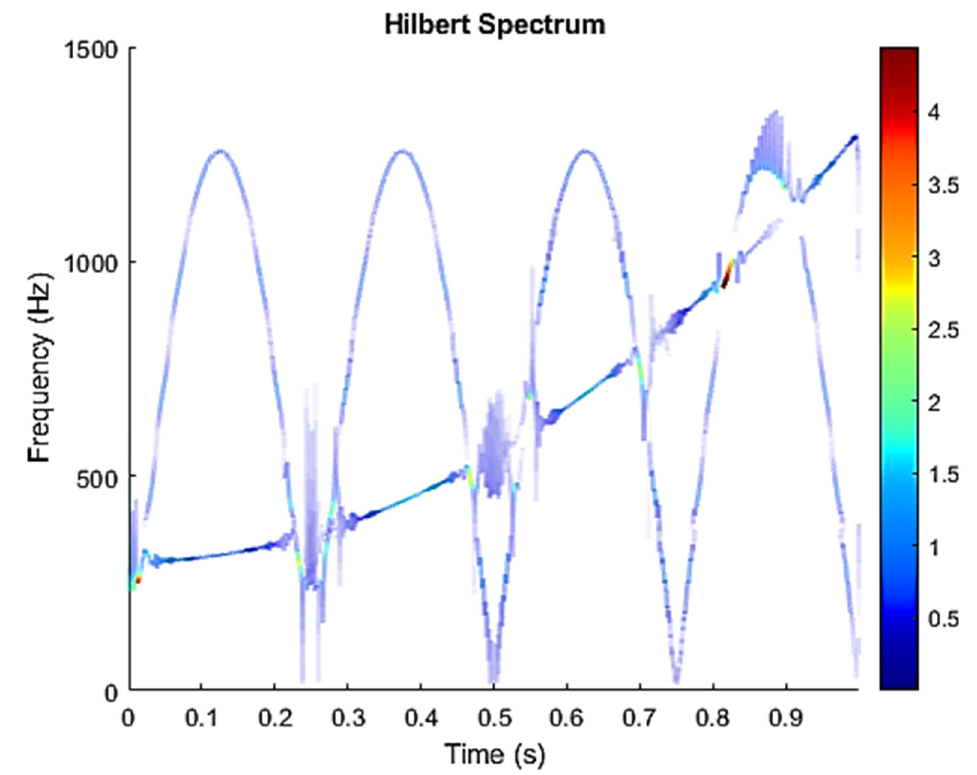
Figure 17. Analysis of data separated by ICA-VMD’s Hilbert Spectrum results.